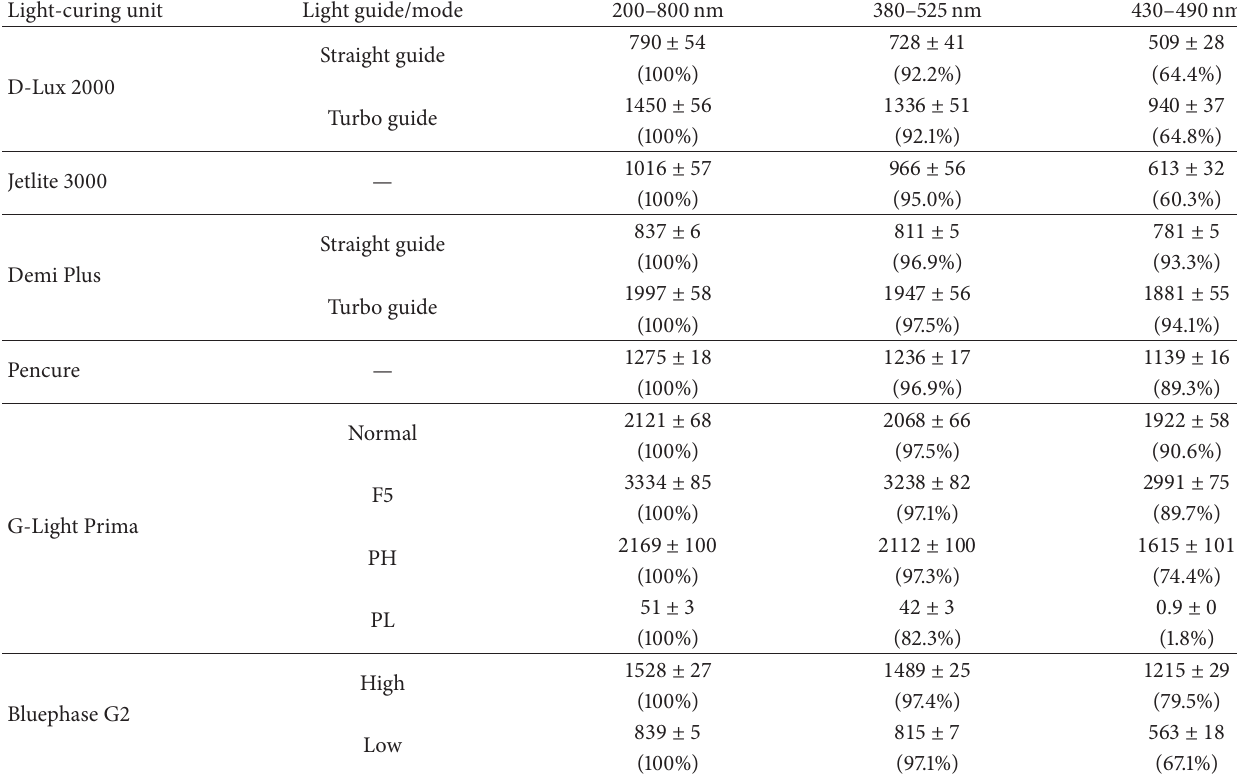
Table 3: Power density calculated from integral value of spectra at 200–800 nm, 380–525 nm, and 430–490 nm ( 𝑛 = 5 , mW/cm 2